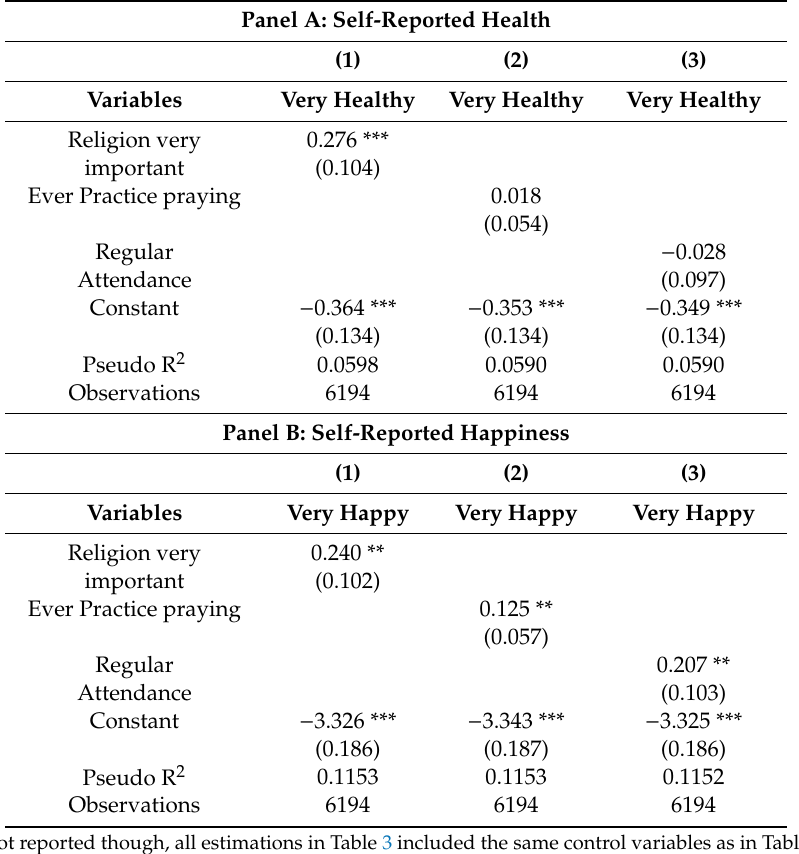
Table 3. Association between health and religious activities (Binary probit